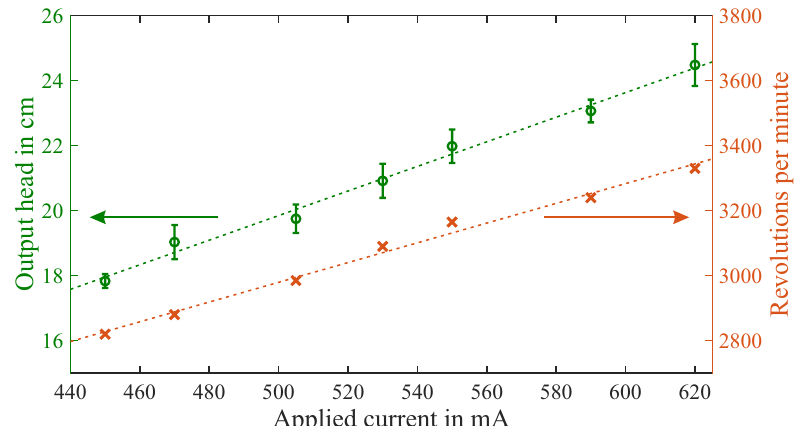
Figure 9. Measurement results for output pressure head (green circles, left axis) and rotation speed (orange crosses, right axis) plotted over applied current, with dashed lines as linear